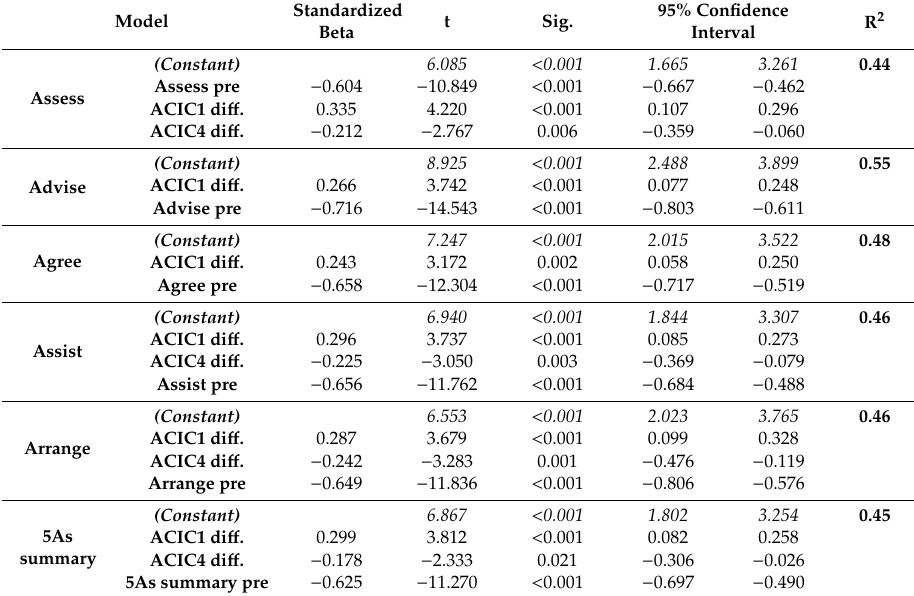
Table 4. Linear regression models of Patient Assessment of Care for Chronic Conditions (PACIC + ) domains at